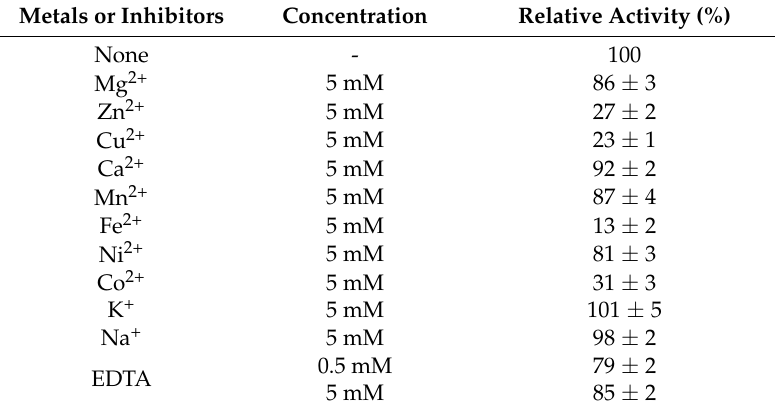
Table 3. Effect of various metals on the enzymatic activity of HSPH ZZ a .